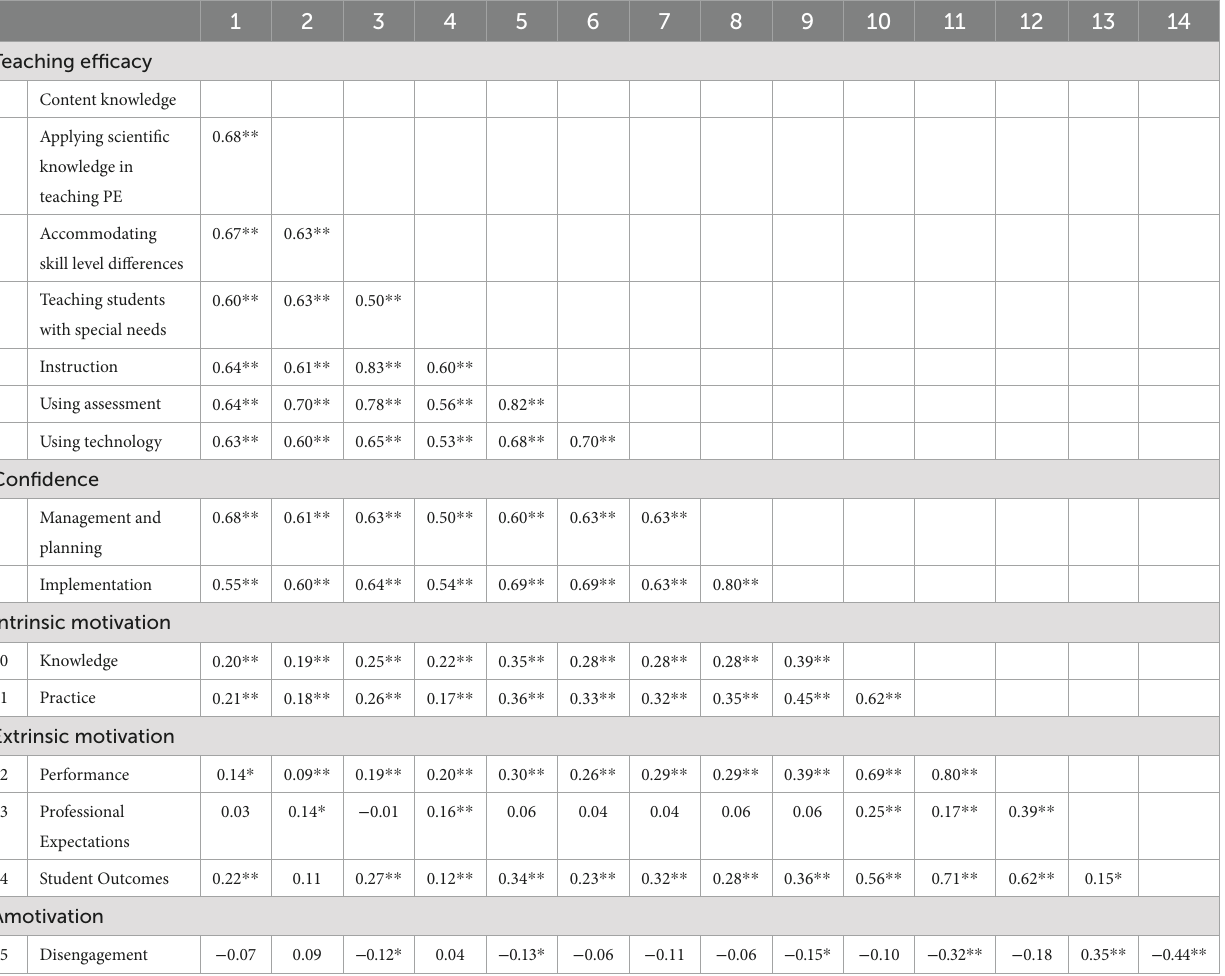
TABLE 7 Pearson’s correlations between confidence and motivation